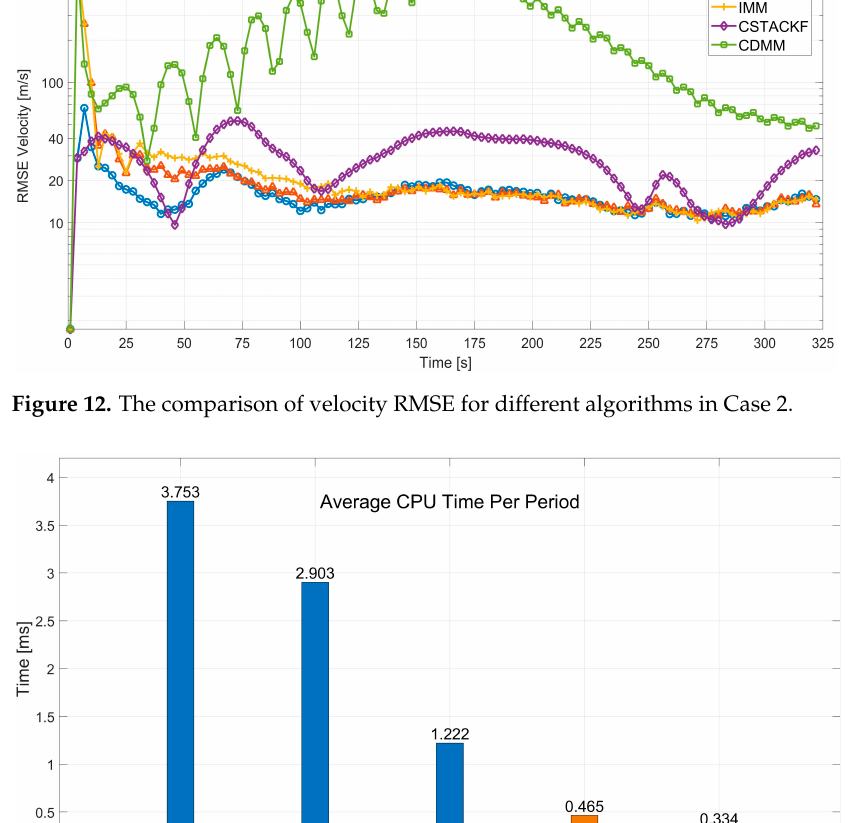
Figure 14. The comparison of the estimated trajectories to the true trajectory in one Monte Carlo run in Case 2. Table 4. The average tracking error of the non-cooperative target in the skip-gliding mode. Algorithm